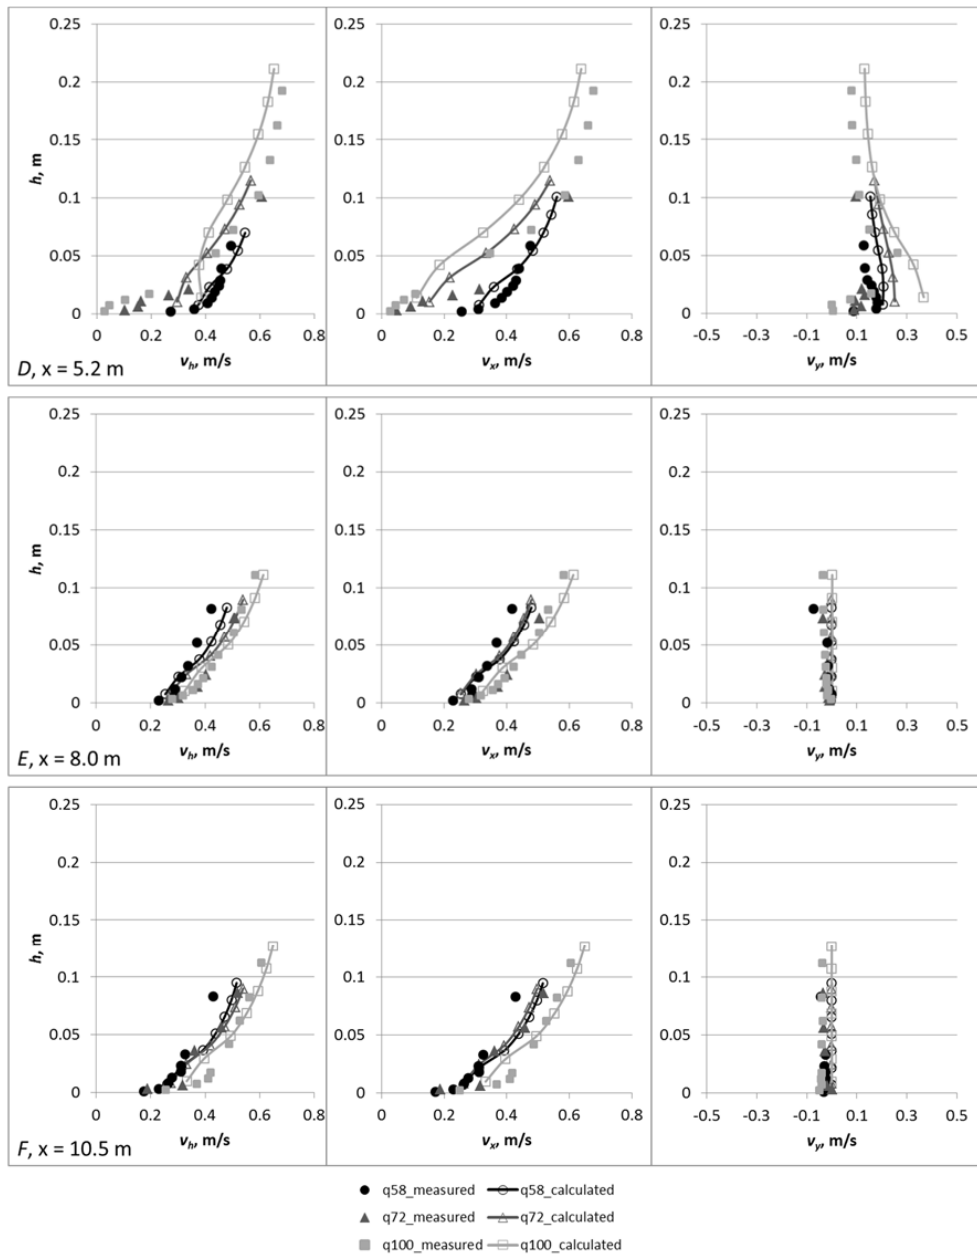
Figure 8. Calculated and measured v hozitontal (first column), v x (second column) and v y (third column) vertical velocity profiles in the three equilibrium states. Three diagrams in a row belong to one vertical component, whose position can be identified by the letters (A, B, C…F) in Figure 7. The y axes show the water depth, while the x axes indicate the horizontal, longitudinal and the transversal velocity values. The model calculation was carried out using k s = 0.84 d 90 As for the transverse velocity components, the deviation from experiments is more substantial.